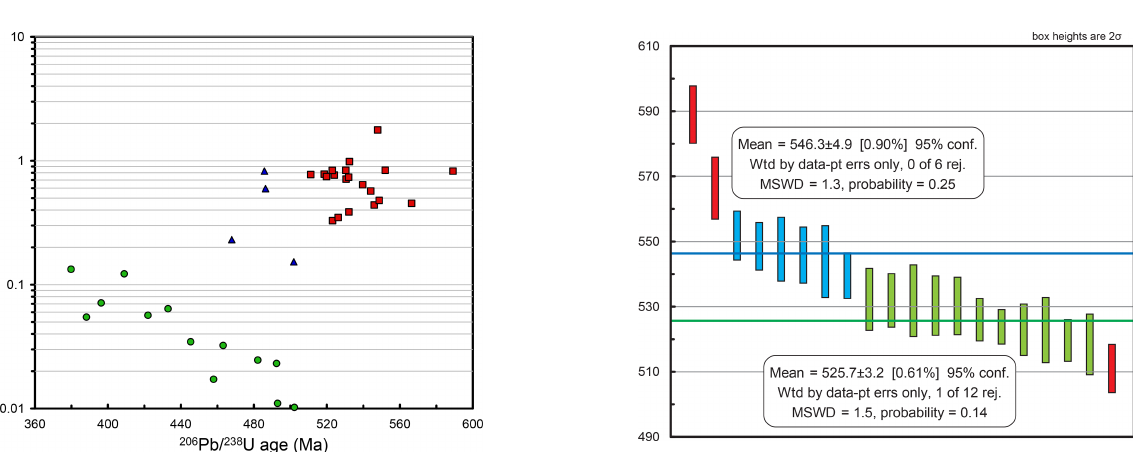
Figure 14. Th / U ratio versus 206 Pb / 238 U ages for the zircon anal- yses from 589 to 380Ma. Analysis 63 (510Ma) is not represented as it has an anomalous value (6.59).